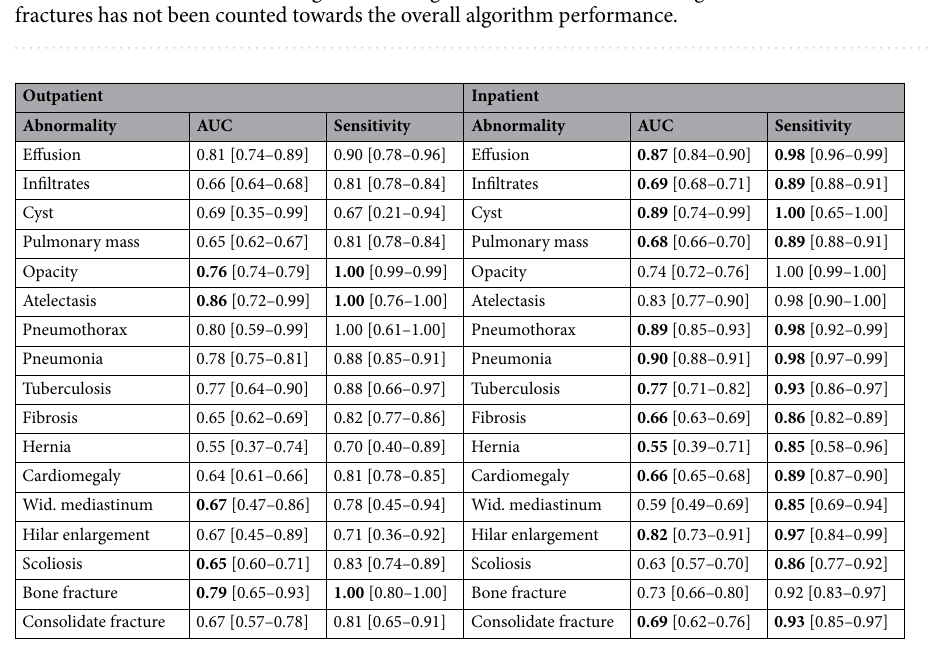
Table 2. The results of proposed framework presented in terms of the area under the receiving operator curve and sensitivity against patients under inpatient and outpatient care. The higher number for each abnormality is highlighted in